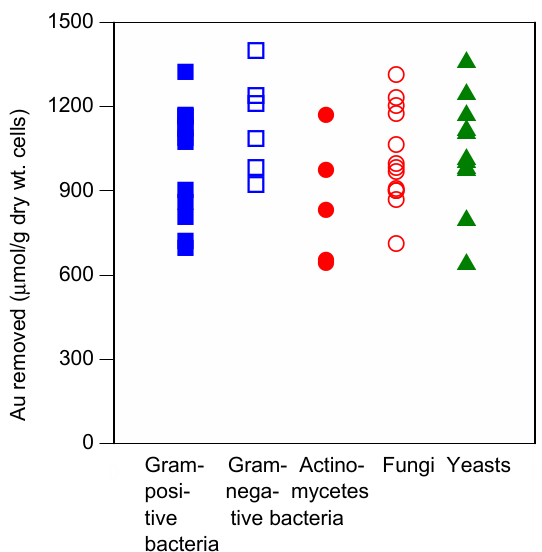
Figure 1. Gold (III) removal from hydrogen tetrachloroaurate (III) solution using microorganisms after 72 h incubation.